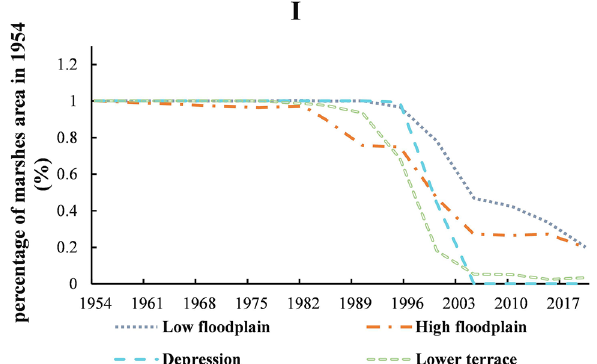
Figure 6. The distribution of marsh during 1954–2020 based on geomorphic types in Heilongjiang_Nongjiang region. Figure shows the marshes in District Heilongjiang_Nongjiang region were mainly distributed on high floodplains, low floodplains, lower terrace, and depression. The degradation of marshes first occurred on the high floodplain, and then appeared in the lower terrace, the floodplain, depressions and low floodplains.